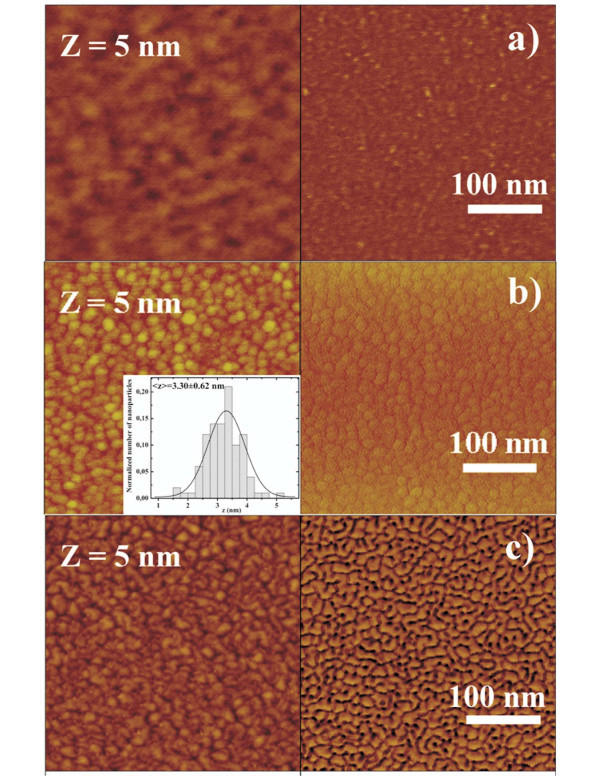
Nanometric scale AFM images of each deposition step of as deposited and annealed samples: (a) AFM images in detail (around micelles) of PnBuA-b-PAA film; (b) AFM images of gold nanoparticles after sputtering deposition, inset: Gaussian distribution of gold nanoparticles' size (height). (c) AFM image in detail of annealed (115°C, 15 min) hybrid bilayer with evidence of the modification of gold film nanostructures.